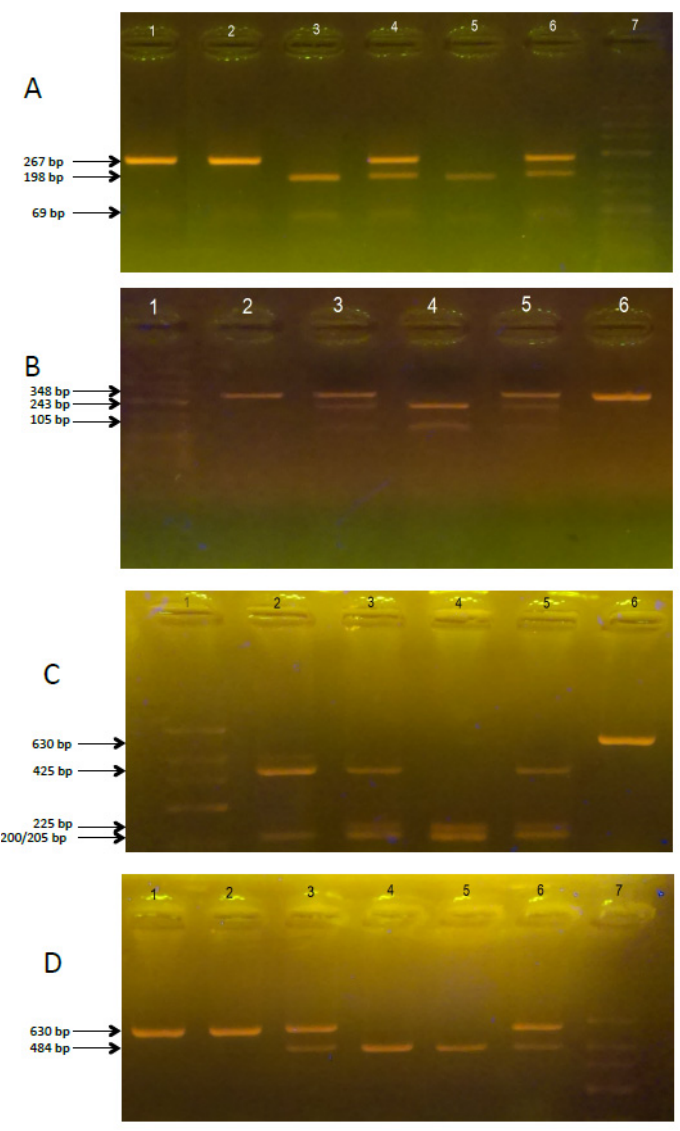
Figure1. The electrophoregram of VDR receptor gene fragments genotyping. ( A )—Fok ‐